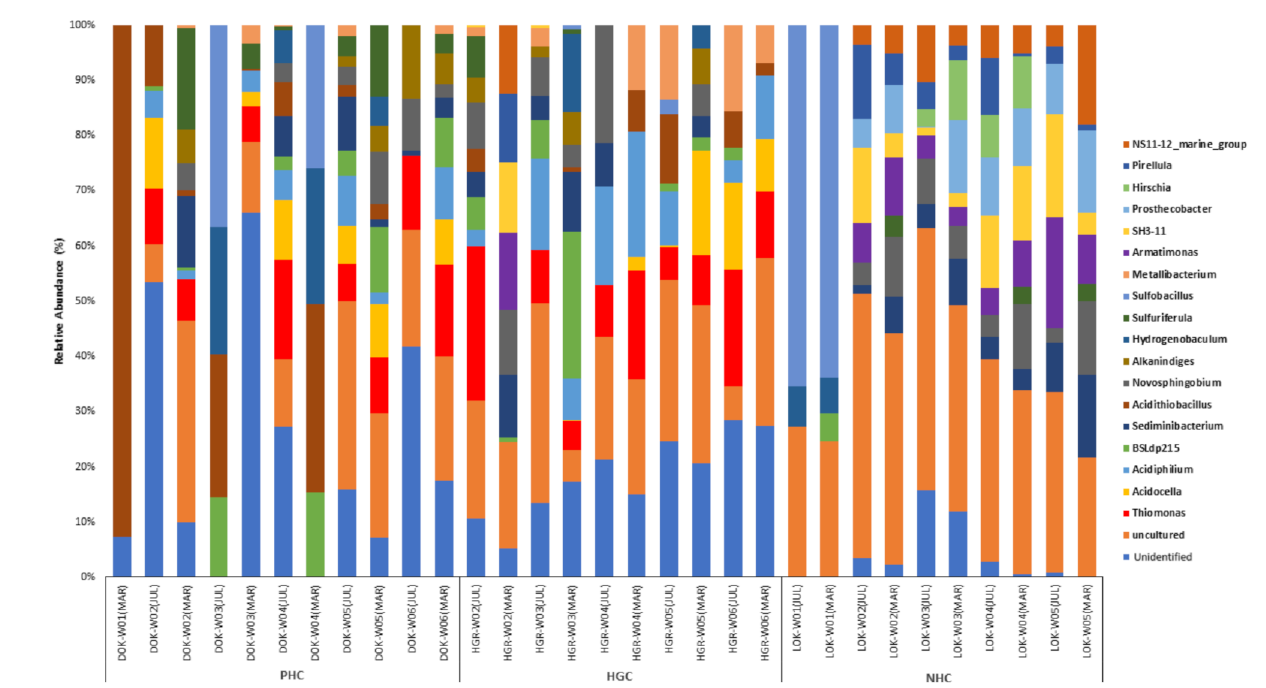
Figure 5. The stacked bar graphs illustrate the relative bacterial genera abundance of the samples of three watersheds in two sampling